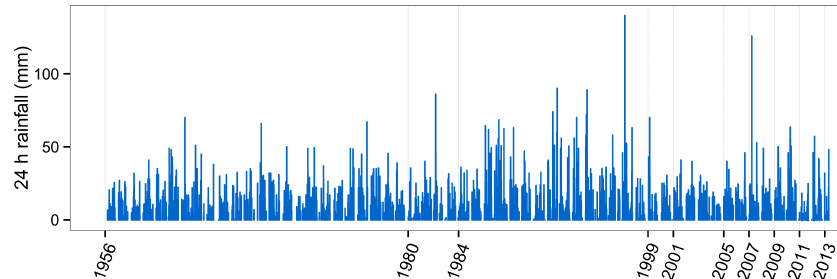
Figure 7. Daily rainfall recorded in the period 1956–2013.